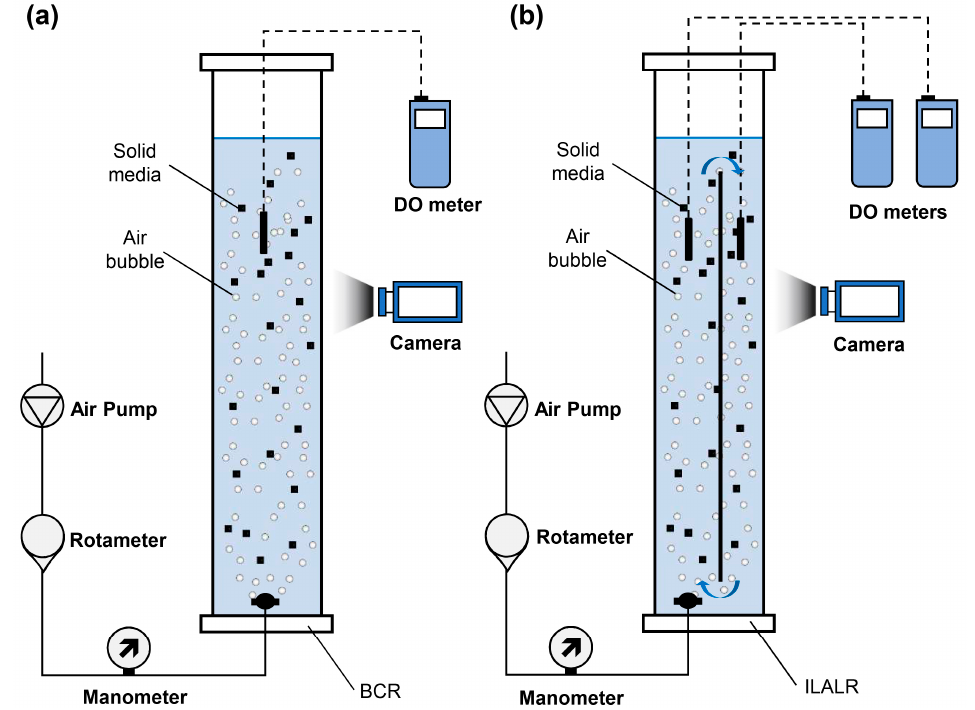
Figure 1. Experiment set-up of: ( a ) bubble column reactor (BCR), and ( b ) internal-loop airlift reactor (ALR).